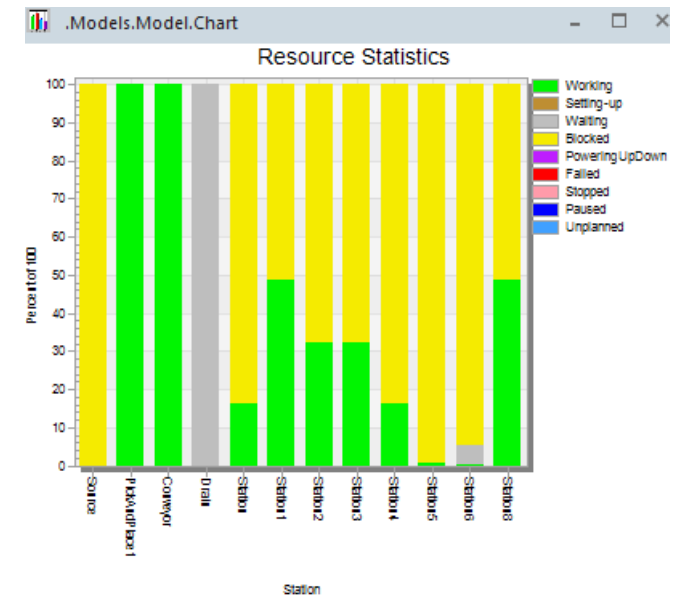
Figure 7. Statistics concerning the work of machines in the production process.